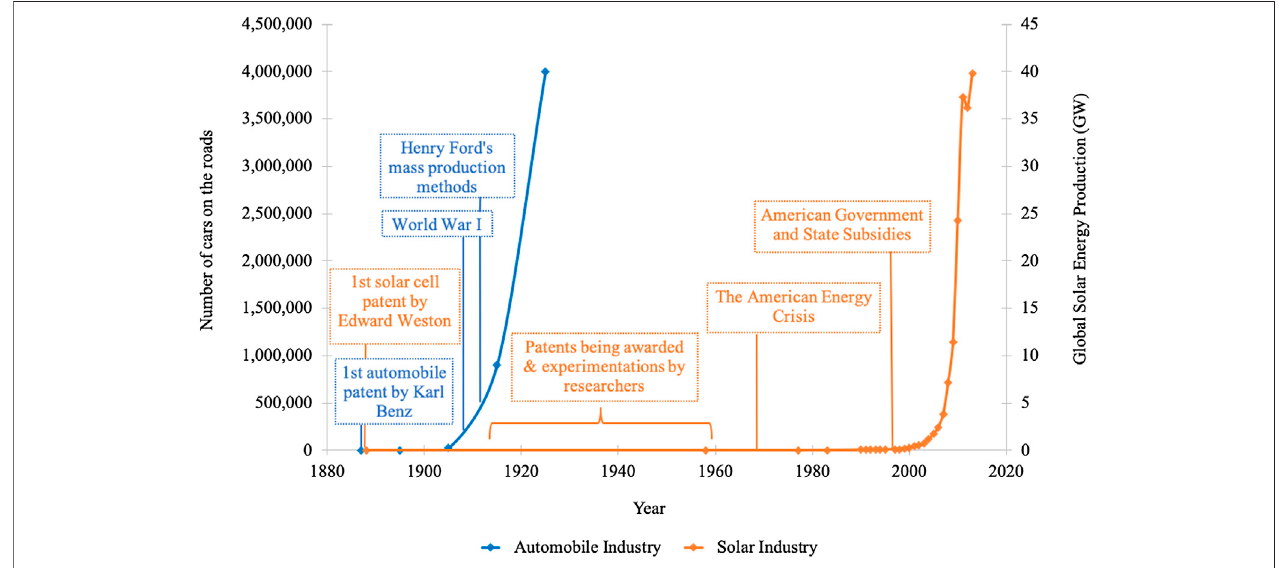
FIGURE 2 | A comparison of the American production statistics of automobiles and horse-carriages/wagons. Values of automobile production obtained from (Grif fi n, 1925). Values of horse-carriages/wagon production units obtained from the US. Department of Commerce archives (Steuart and Hawes, 1918).